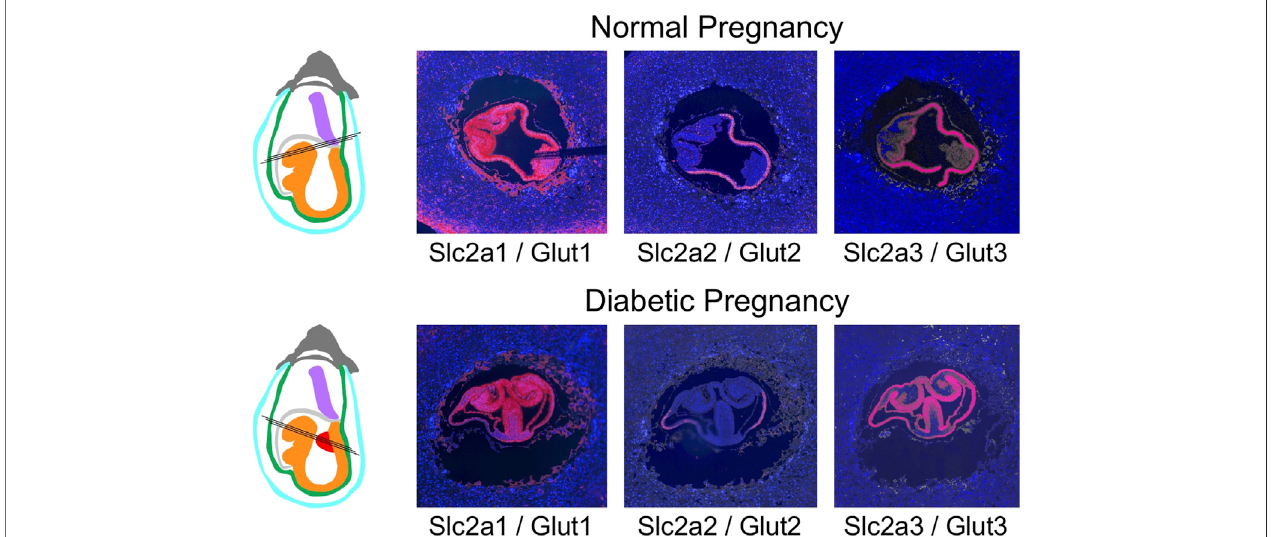
FIGURE 7 | Comparison of glucose transporter expression in decidua of normal and diabetic pregnancies at E8.5. Decidua from normal and diabetic pregnant females of the NOD mouse strain were isolated at E8.5, and serial sections were produced; their orientations are indicated by black lines. The color code for the schematic representations is the same as for Figures 4 – 6 , with the addition of ectopic tissue protrusions (red) that are speci fi cally observed in a fraction of embryos in NOD diabetic pregnancies. These protrusions from the embryonic midline encompass embryonic mesodermcovered by neuropeithelium, and those embryo-derived cells display the same nutrient transporter expression patterns as normal embryonic mesoderm and neuroepithelium.